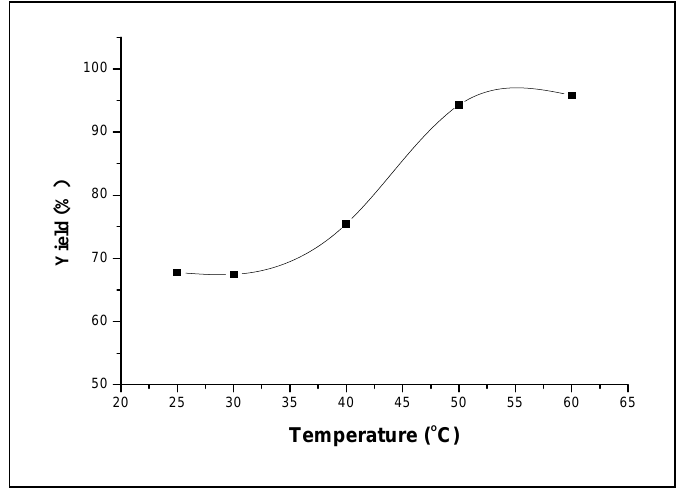
Figure 9. Influence of the reaction temperature on the polymerization of styrene. Polymerization was carried out in dichloromethane (St/DCM (volume ratio) = 0.4.) using PW O 0.025 g of H 3 12 40